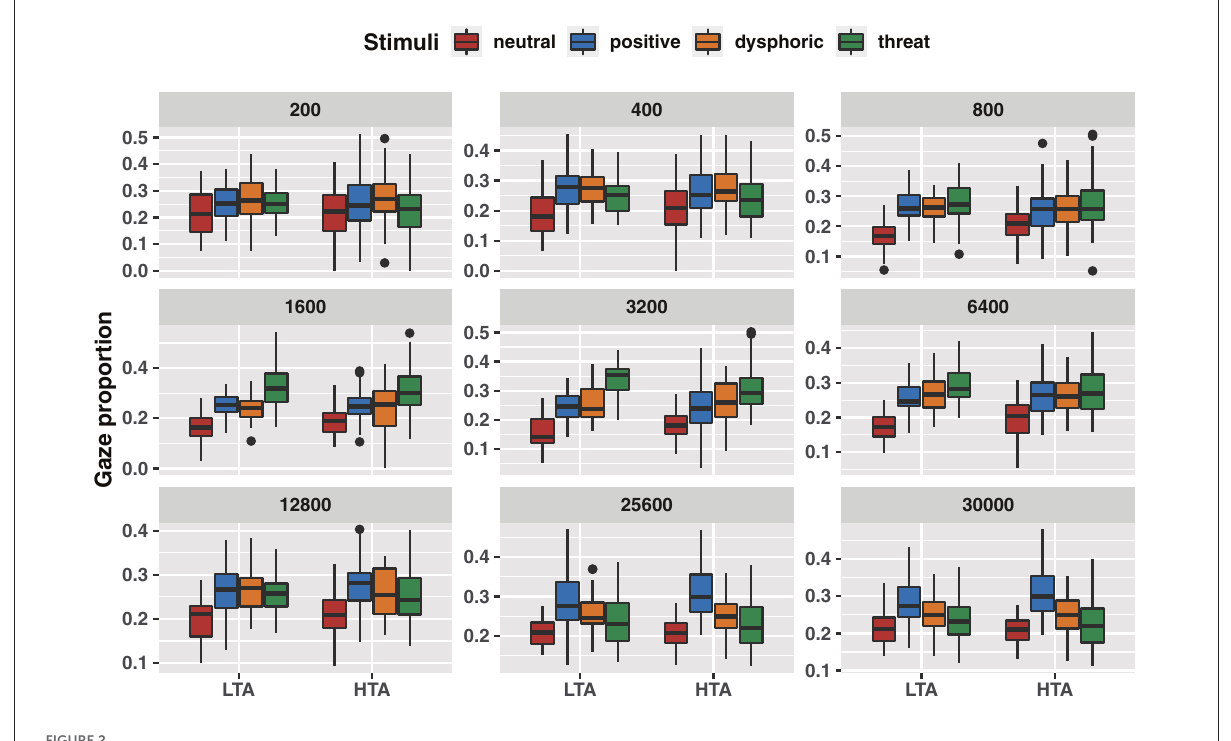
FIGURE2 Differences in attentional bias between emotional stimuli with different stimulus durations.